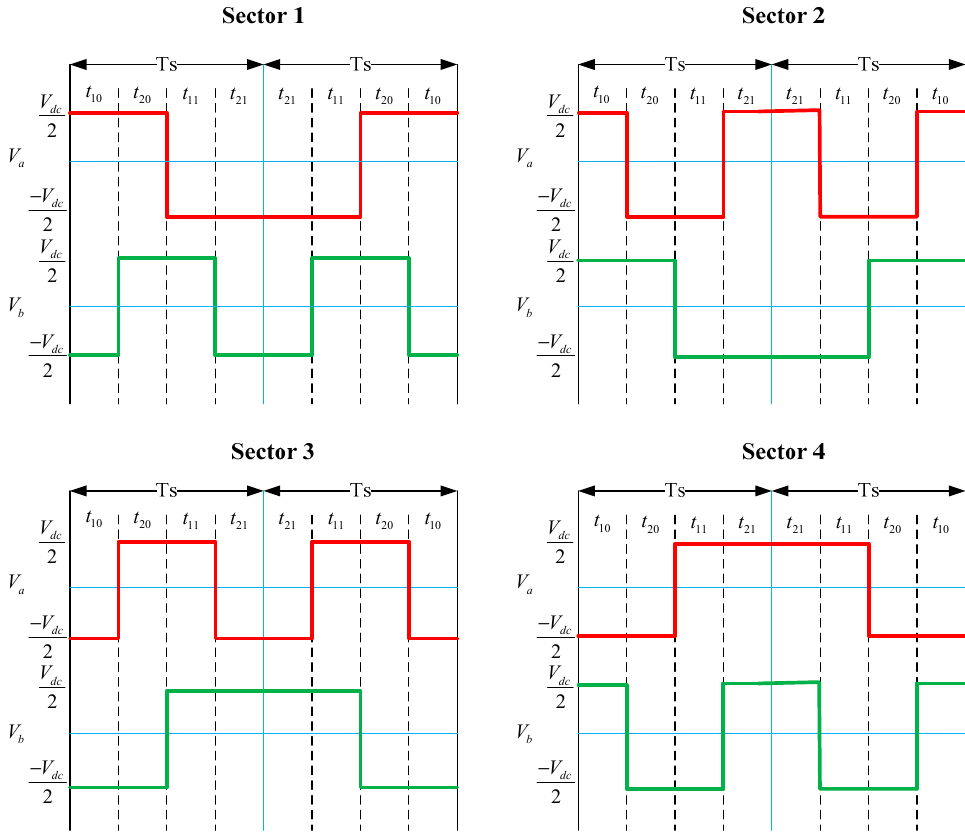
Figure 6. 2 ϕ -inverter output voltages by the conventional SVM symmetrical modulation. Figure 6. 2 φ -inverter output voltages by the conventional SVM symmetrical This leads to switching loss increase because the output voltage is discontinuous at the sector boundary. In addition, the significant surge is involved in the output current and therefore the ripples are significant. In order to eliminate the previously mentioned 2 ϕ symmetrical modulation disadvantages, the advanced technique is applied in switch- ing operations, ensuring that the output voltage becomes continuous at the boundary be- tween sectors. In this case, the PWM voltage waveforms are uniform and easy to imple- ment because the switching logic is regular. Hence, during T s , the inverter leg of phase A is carried out with one switching at t = t A , while that of phase B proceeds with two switch- ing, namely at t = t B 1 and t = t B 2 , based on the specific calculating method, as summarized in Table 2. Table 2. Switching arrangement for the advanced SVM symmetrical modulation realization. State